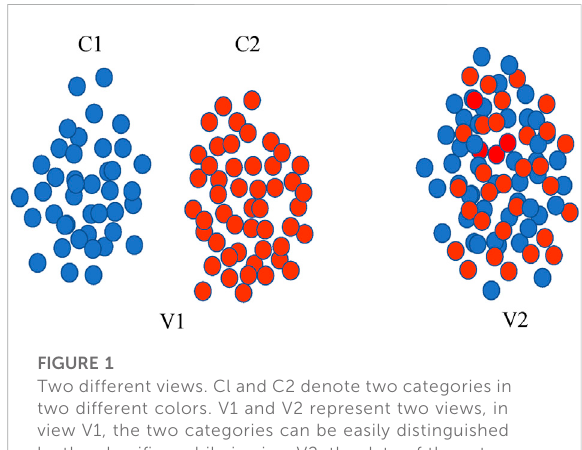
FIGURE 1 Two different views. Cl and C2 denote two categories in two different colors. V1 and V2 represent two views, in view V1, the two categories can be easily distinguished by the classi fi er, while in view V2, the data of these two categories are mixed and dif fi cult to